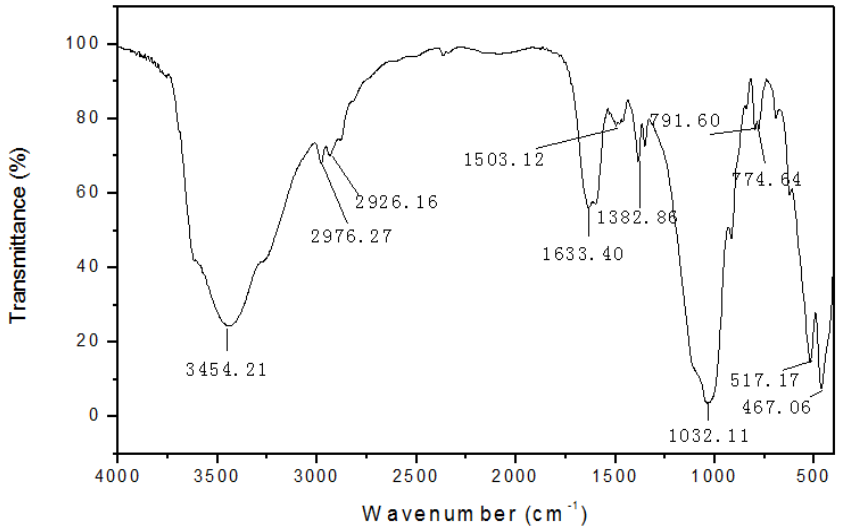
Figure 3. Infrared spectra of polyamine modified soil.